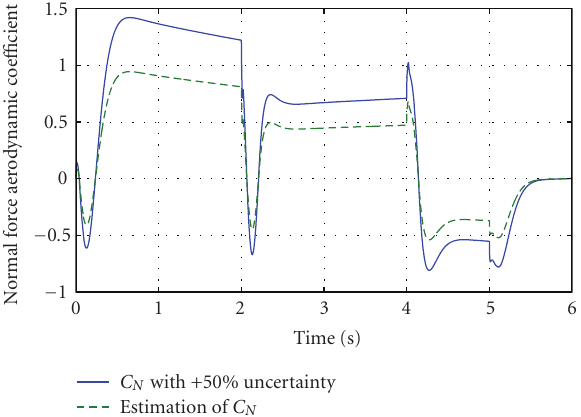
Figure 5: Nominal force aerodynamic coe ffi cient estimation with adaptive scheme.